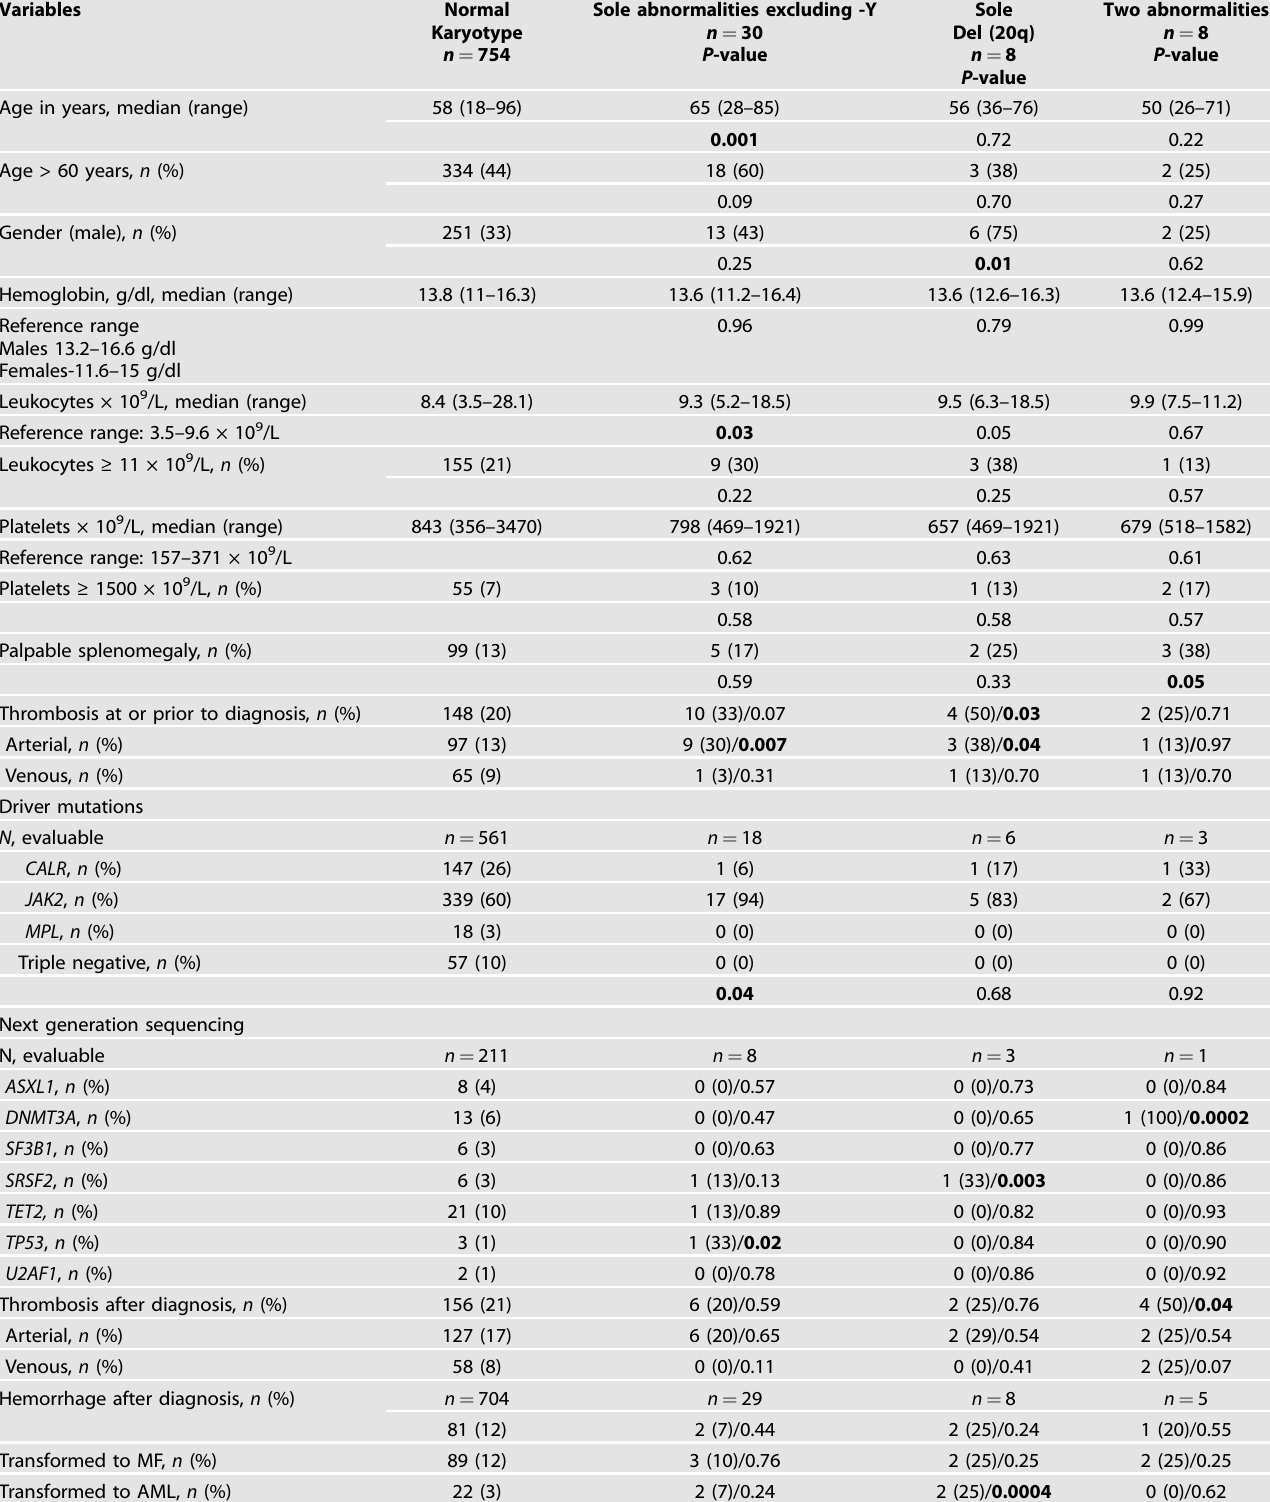
Table 3. Phenotypic and molecular correlations of Essential Thrombocythemia (ET) patients with sole abnormalities, del(20q) and two abnormalities in comparison to normal